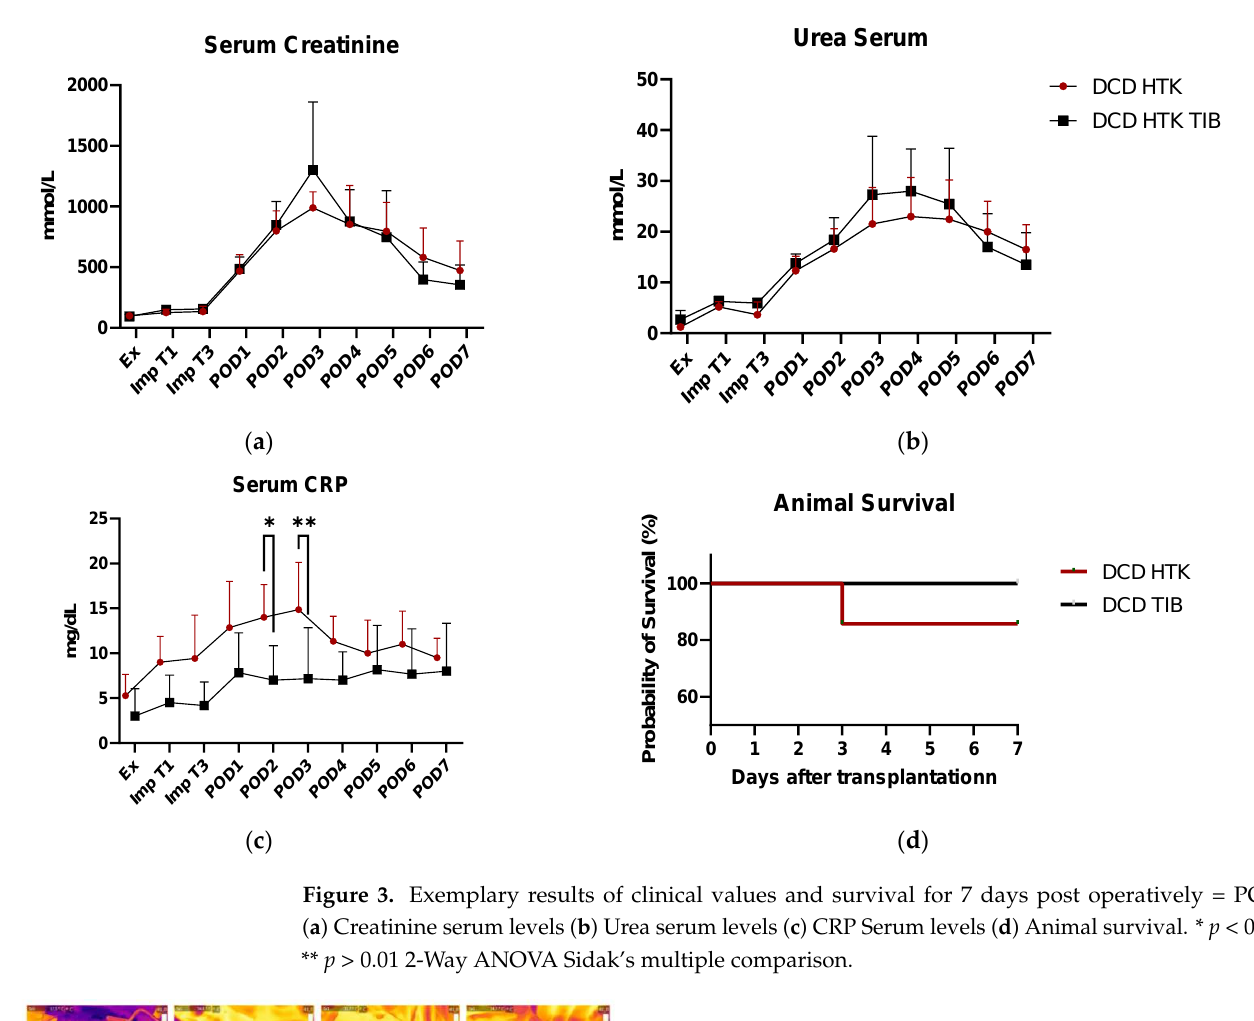
Figure 4. Thermographic Imaging. ( a ) Exemplarily illustration of the thermal camera imaging dur- ing reperfusion. ( b ) The graph shows the determination of surface temperature over time of 80 s.